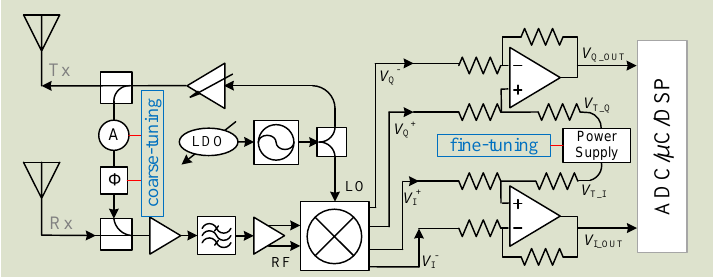
Figure 9. Block diagram of the Doppler radar with DC coupled architectures including RF coarse-tuning and baseband fine-tuning.